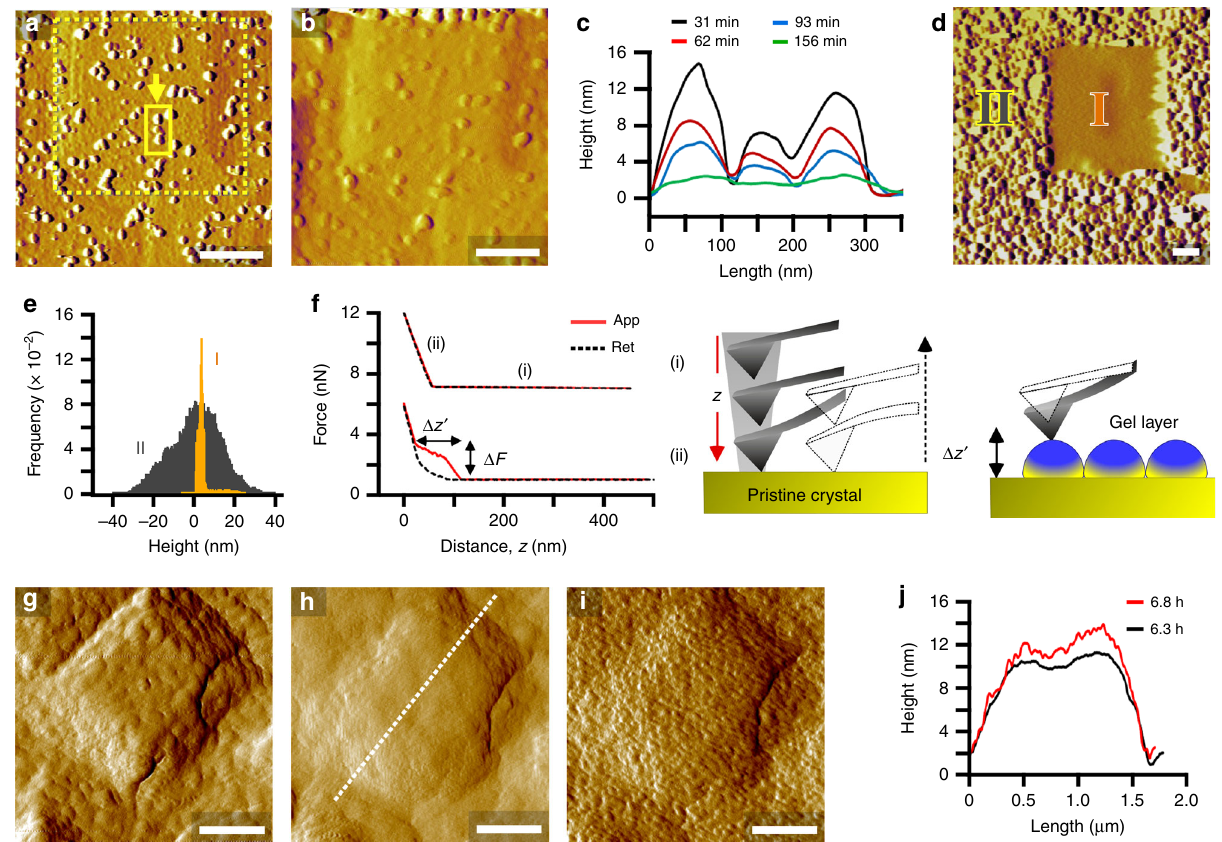
Fig. 2 Three-dimensional growth of gel-like islands. a , b AFM amplitude mode images of a crystal surface at 35 °C in solution S2 (high supersaturation): a 30 min after reaching the set point temperature and b after 3 h of continuous imaging. c Time-resolved height pro fi les of the region highlighted by the arrow in a . d Enlarged scan area showing (I) a smooth region after 8 h of continuous imaging in tapping mode and (II) the surrounding rough region. e Statistical analysis of feature heights in regions I and II of image d (see also Supplementary Fig. 7). f CFM approach – retract curves as a function of distance z from substrates in solution S2 before heating (top) and after heating for 3 h (bottom). The schematics depict an AFM tip far from the surface (i) and in contact with the surface (ii). CFM on gel interfaces yields nonlinear approach curves with characteristic force Δ F and z-height Δ z ’ . g – i Amplitude mode images of a crystal surface in solution S3 at 35 °C; g 30 min after reaching the set point, h after 6.3 h of imaging, and i the same area after removing the AFM tip from the surface for 30 min and reimaging. j Height pro fi les along the dashed line in h for times 6.3 and 6.8 h (i.e., h and i , respectively). Scale bars are equal to 500 nm unless otherwise